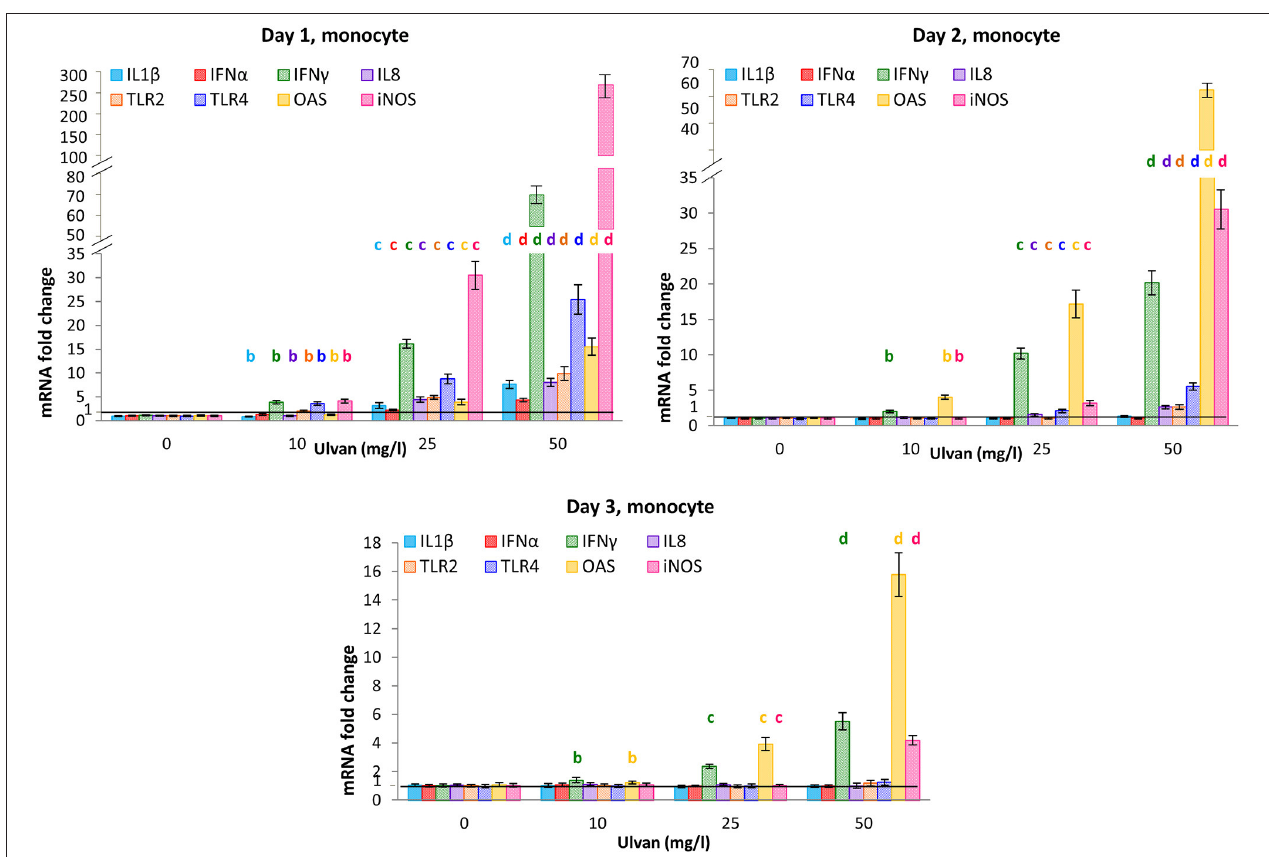
FIGURE 6 | Cytokines mRNA are transcribed in monocytes in response to ulvan. Ulvan was given per os at four different concentrations (0, 10, 25, 50 mg/l) to the animals at day 0. Blood samples (1ml per animal) were taken from day 0 to day 3. Cellular pellets of three animals were pooled to obtain sufficient number of cells for purification and RT-qPCR. Data represents the mean ± SEM of three independent experiments with 25 chickens per group. Different letters with the same color indicate statistically different values for the different doses at the same time with p <